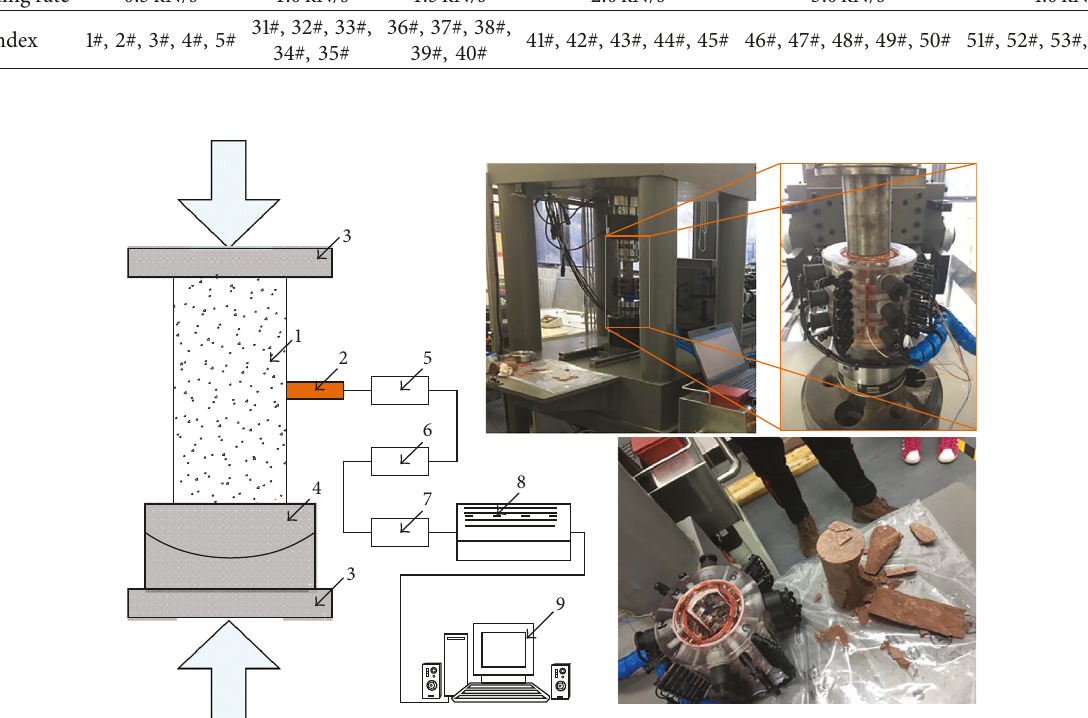
Figure 1: Schematic diagram of the AE measurement. 1: rock specimen; 2: AE sensor; 3: loading platens of the testing machine; 4: spherical adapter; 5: AE per-amplifiers; 6: filters of AE signals; 7: analog-to-digital converter; 8: signal acquisition unit; 9: data analyzer. (a) Combined experimental platform; (b) postfracturing rock